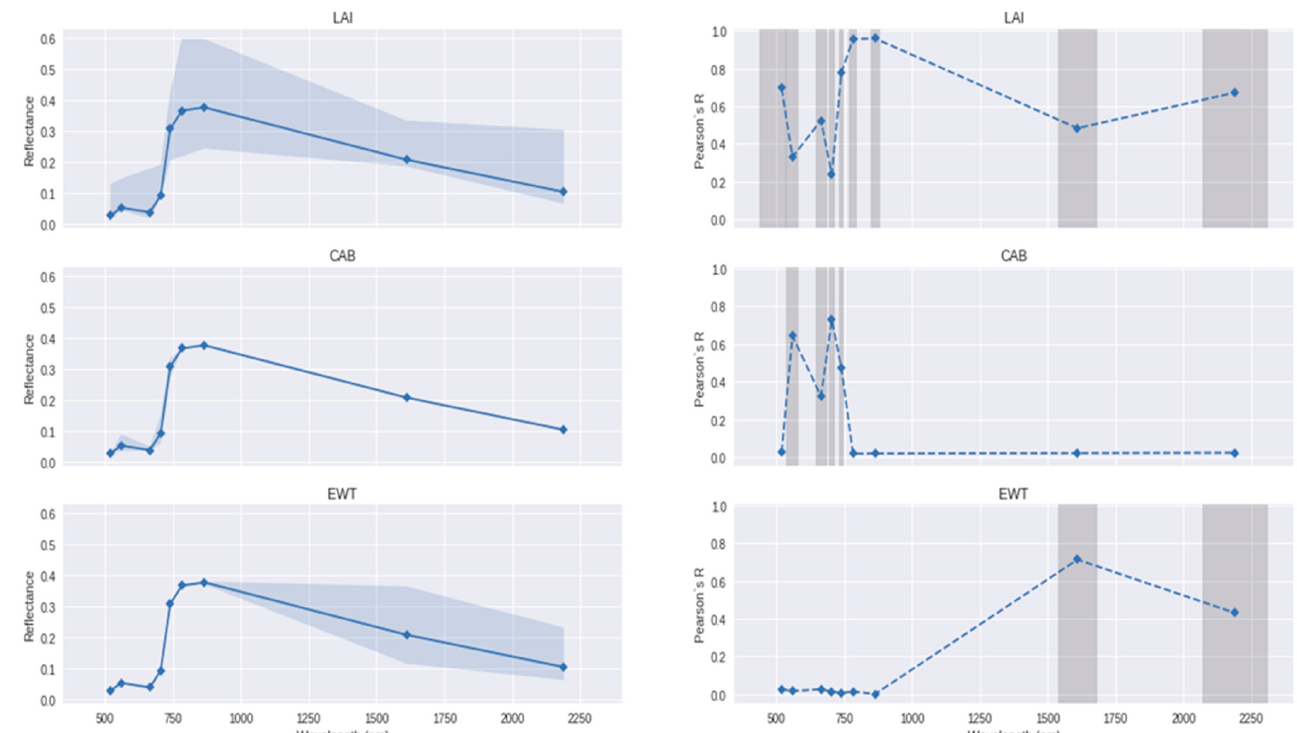
Figure A2. Sensitivity analysis of PROSAIL’s LAI, CAB, and EWT parameters to the spectral layout of Sentinel-2 MSI bands used in this study. The left pane illustrates the range of variability in spectral response to changes in the parameters, while all other parameters were kept constant in the modes defined in [58]. The right pane depicts the correlation (Pearson’s R) of different bands to changes in the parameters using a range of simulations defined in [58]. Significant correlations are indicated by the grey highlighted bars.